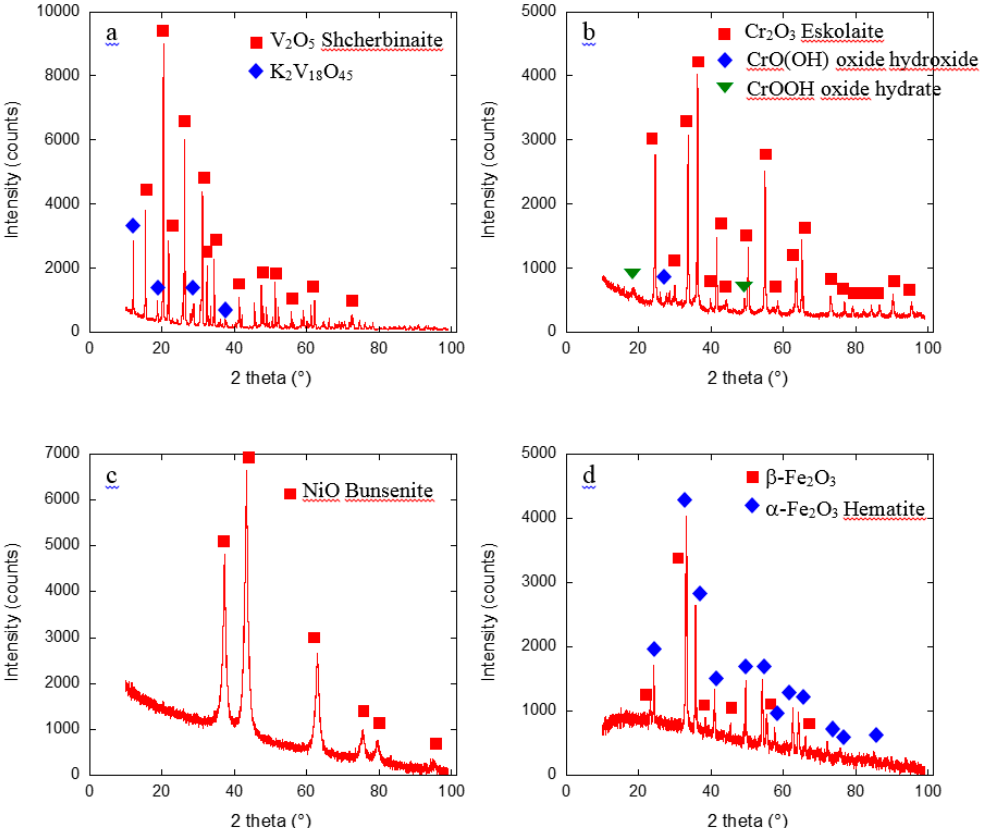
Figure 9. XRD patterns of nano/micro-oxides derived from calcination in air at 550 °C after HTC of tannin solutions containing: ( a ) V; ( b ) Cr; ( c ) Ni; and ( d ) Fe salts. The symbols above the main peaks correspond to the crystalline phases indicated on each plot.